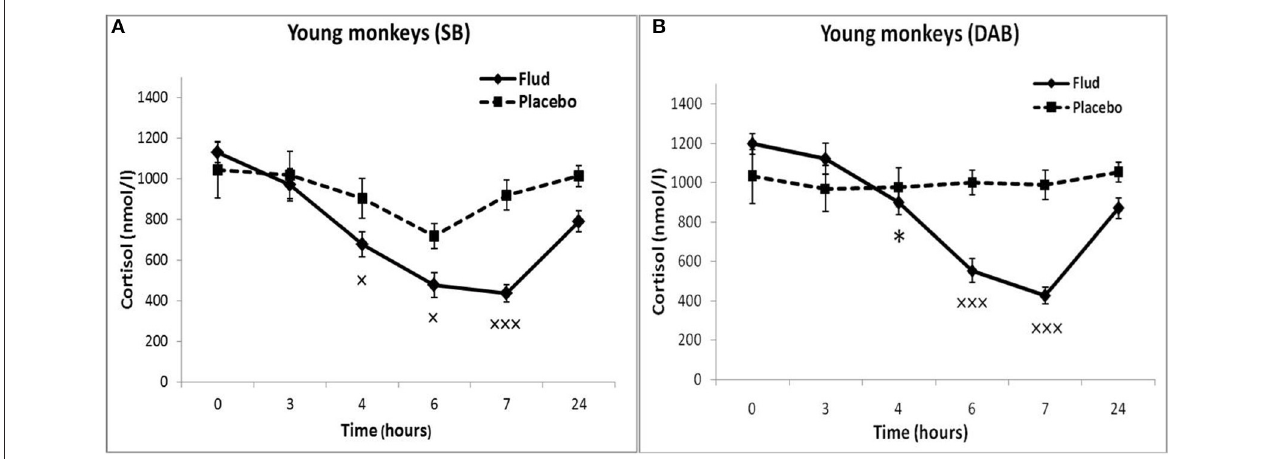
FIGURE 1 | Dynamics of CORT concentration in peripheral blood plasma of young female rhesus monkeys with SB and DAB in response to administration of fludrocortisone and placebo (mean ± S.E.M). * p < 0.05 vs. relative values in animals with SB ( F = 5.26; df = 1;15; p = 0.037). × p < 0.05, ××× p < 0.001 vs. placebo. (A) (SB): 4h ( F = 6.038; df = 1;11; p = 0.049), 6h ( F = 7.768; df = 1;11; p = 0.0199), 7h ( F = 30.995; df = 1;11; p = 0.00035). (B) (DAB): 6h ( F = 28.619; df = 1;15; p = 0.0003), 7h ( F = 69.161; df = 1;16; p = 0.000159).